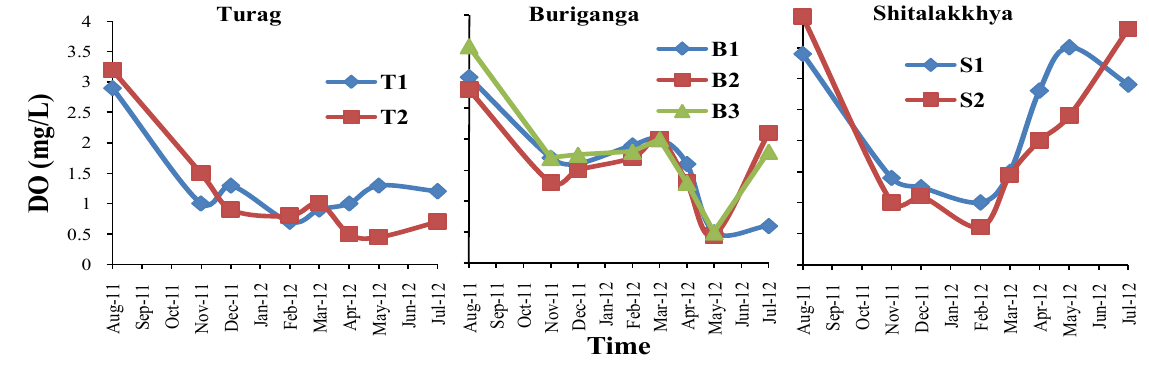
Figure 7. The dissolved oxygen (DO) values of the samples from the water of three different rivers around Dhaka City.